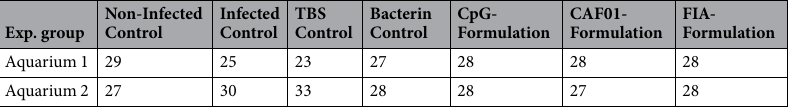
Table 2. Individuals per aquarium during the experimental